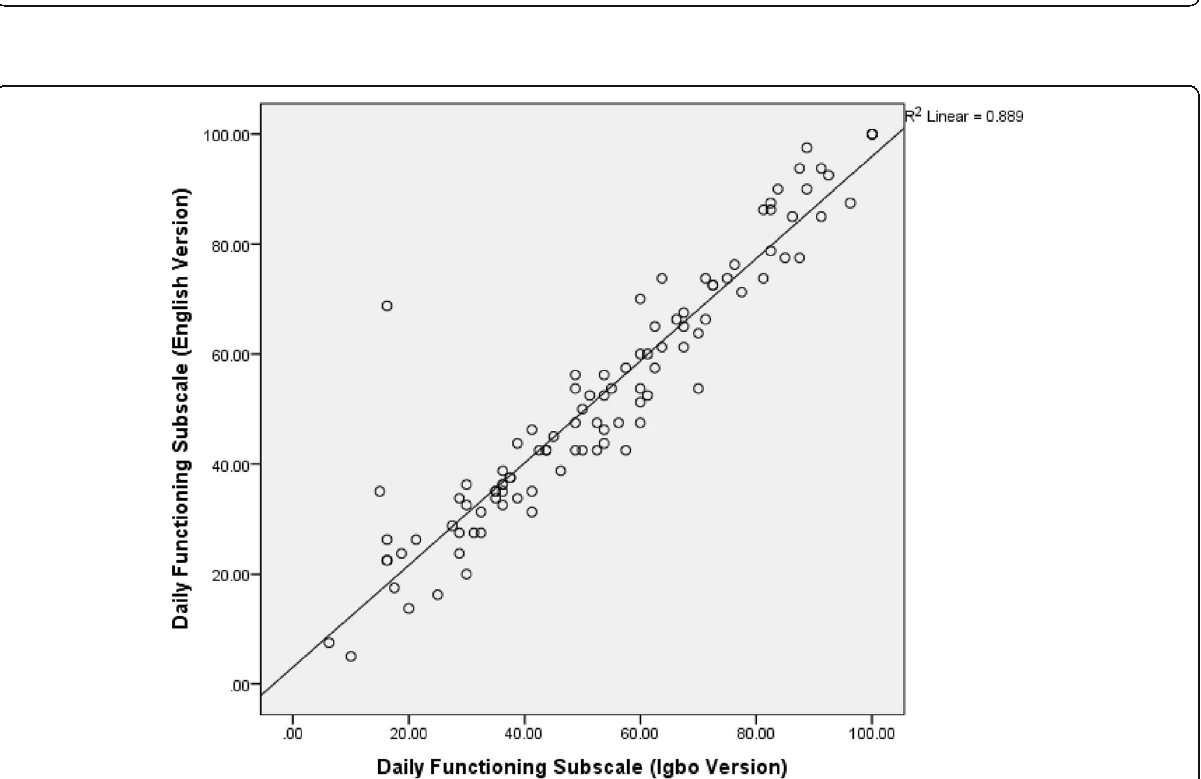
Fig. 1 Scatter diagram for total scores on the E-RNLI and the I-RNLI. KEY : I-RNLI = Igbo version of Reintegration to Normal Living Index. E-RNLI = English version of Reintegration to Normal Living Index